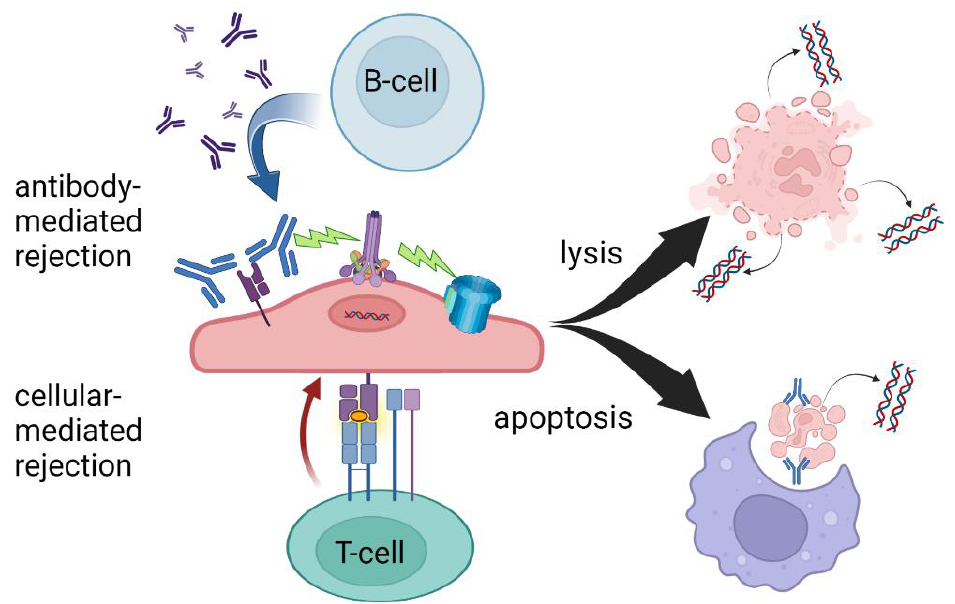
Figure 1. T-cell- and antibody-mediated rejection leading to cell lysis and/or apoptosis. While there is significant overlap in the mechanisms of AMR and TCMR, ddcfDNA levels may be more sensitive to AMR due to increased circulating cellular debris following cell lysis. Created with